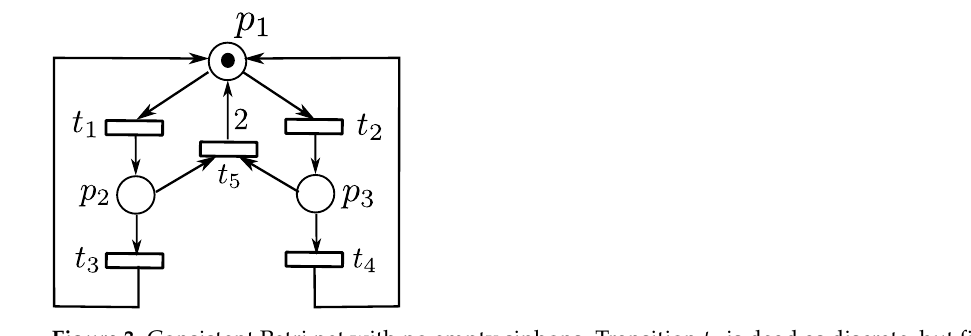
Figure 3. Consistent Petri net with no empty siphons. Transition t 5 is dead as discrete, but fireable as